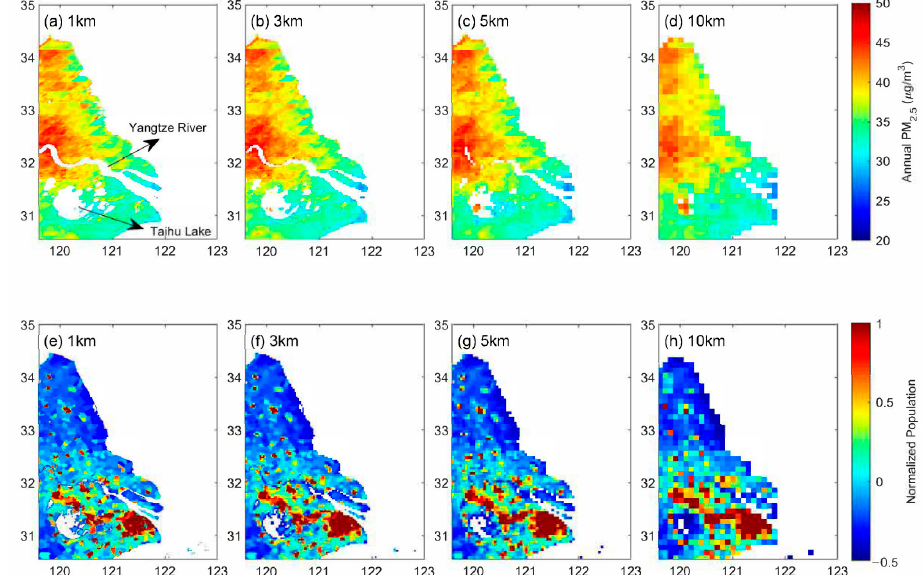
Figure 11. Spatial distribution of (top panels) annual PM 2.5 estimated by the Random Forest (RF) model and (bottom panels) population in northeast YRD (sub-region 1 in Figure 1a) for the resolutions of ( a , e ) 1, ( b , f ) 3, ( c , g ) 5 and ( d , h ) 10 km. Population data in bottom panels are normalized by using standardized z-scores.